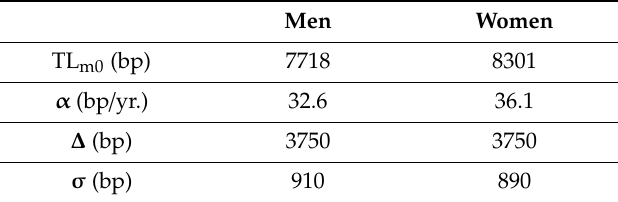
Table 1. Values of 4 telomere measurement-based parameters.